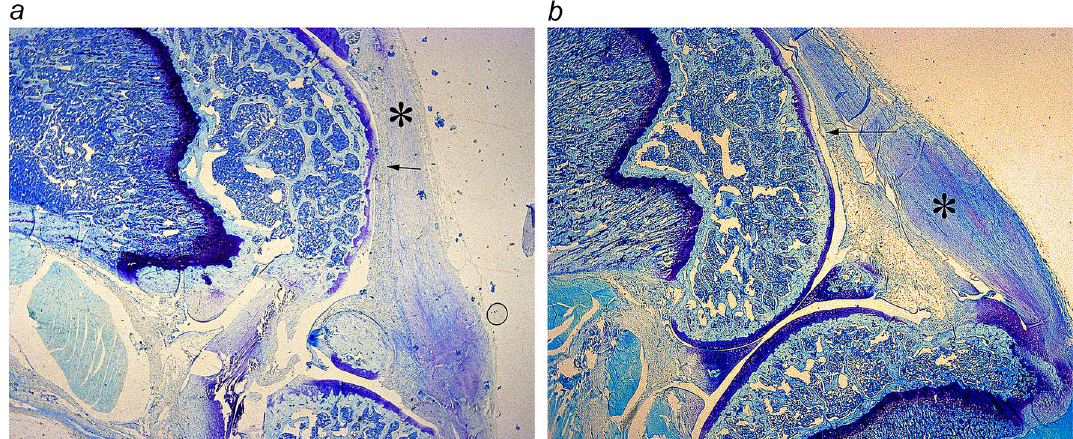
Figure 6. MT-SYK-03 protects against cartilage damage after medial meniscal tear in rats. Photomicrographs of sagittal cross Sects. (10 × magnification) of knee 21 days after medial meniscal tear surgery are shown for: ( a ) vehicle group; ( b ) treatment with MT-SYK-03 (500 mg/kg) group. Arrows indicate erosions, asterisks indicate thickening of the joint capsule.